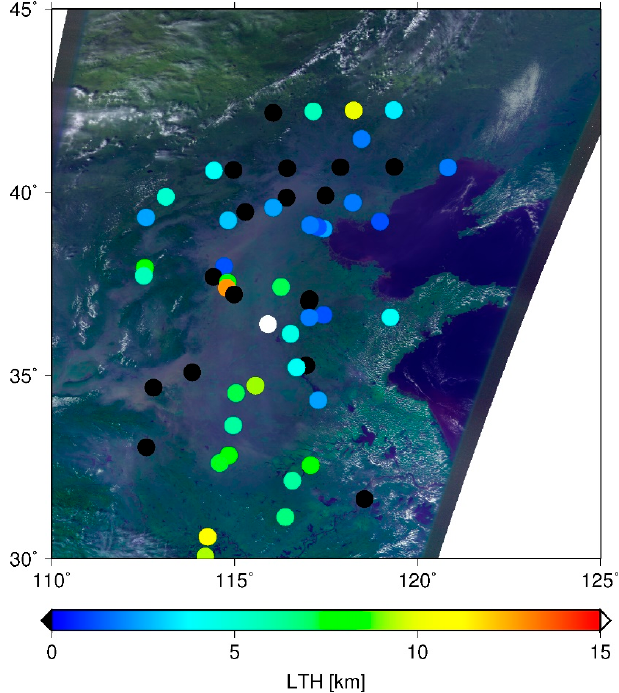
Figure 1. Distributions of the LTHs detected using the slicing method and the corresponding CAI image in eastern China on 9 October 2010. The LTHs detected by slicing are shown in color; black shows detection as clear.